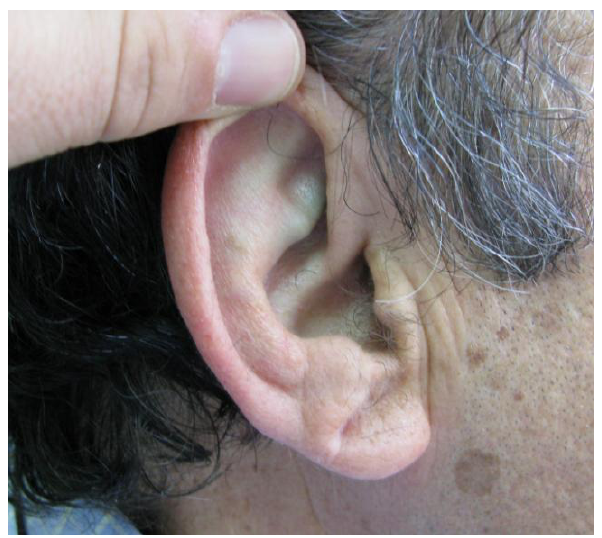
FIGURE 2 . The (R) ear with blue-gray